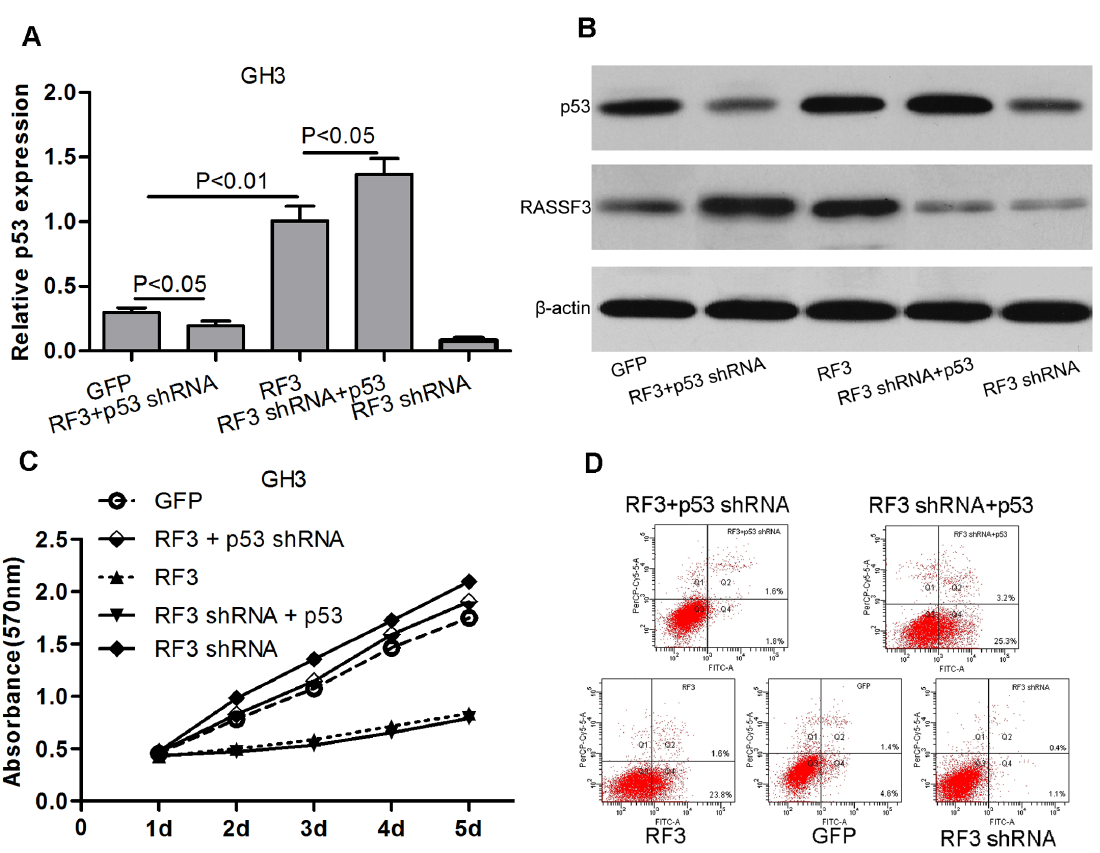
Figure 6. RASSF3-induced apoptosis is p53 dependent. (A) Compared with the Lenti-RASSF3-transfected GH3 cells, qRT-PCR analysis demonstrated that Lenti-P53 shRNA reduced p53 expression by 81%. Compared with Lenti- RASSF3 shRNA GH3 cells, Lenti-p53 increased p53 mRNA expression by 17.1-fold in Lenti-RASSF3 shRNA-transfected GH3 cells. (B) Western blotting analysis for RASSF3, p53. (C) Proliferation in GH3 cells was measured by MTT assay after Lenti-p53 shRNA transfection of Lenti-RASSF3-transfected GH3 cells, and Lenti-p53 transfection of Lenti-RASSF3 shRNA- transfected GH3 cells. Absorbance was read at 570 nm and the average was calculated for 3 wells. p53 suppression blocked the effect of RASSF3 on cell proliferation, and p53 overexpression showed a similar effect to RASSF3. (D) Apoptosis in GH3 cells was measured by Annexin V/PI staining following Lenti-p53 shRNA transfection of Lenti-RASSF3-transfected GH3 cells, and Lenti-p53 transfection of Lenti-RASSF3 shRNA-transfected GH3 cells. Early apoptotic cell populations were significantly decreased after Lenti-p53 shRNA transfection, and increased after Lenti-p53 transfection.